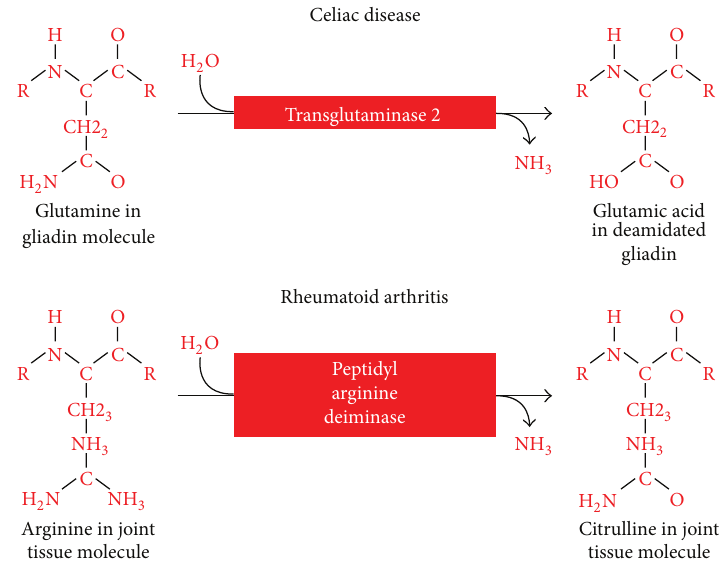
Figure 13: The central role of catalytic enzymes in celiac disease and rheumatoid arthritis. Key enzymes that catalyze the modification of glutamine to glutamic acid or arginine to citrulline as new epitopes have a central role in CD and